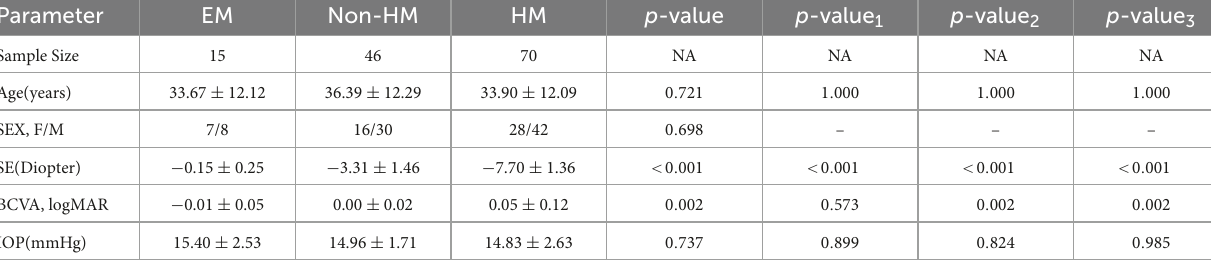
TABLE 2 Demographics and clinical measurements by groups.